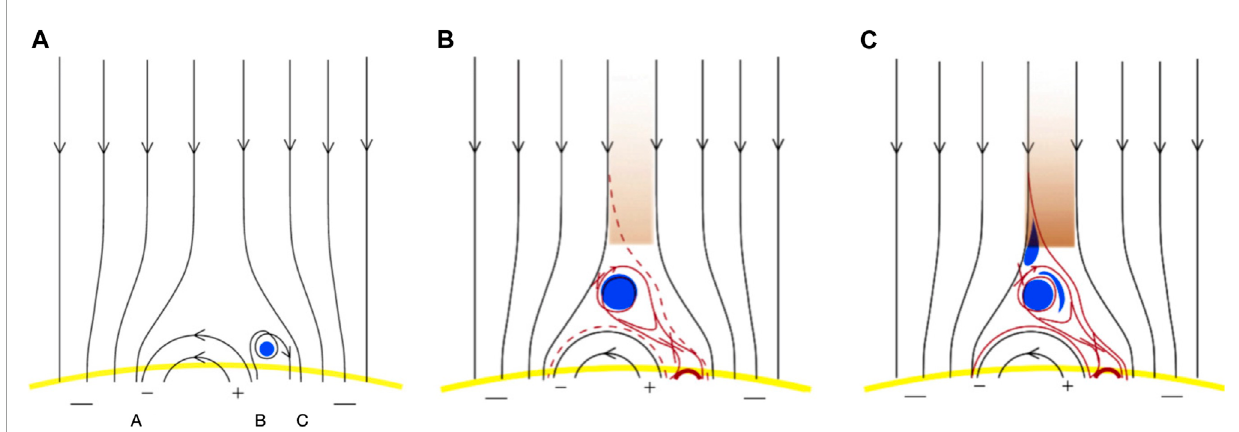
FIGURE 2 Schematic showing the minifilament-eruption mechanism for coronal jets, from Sterling et al. (2015) (this slightly modified version of the original figure appeared in Sterling et al., 2018). This is a two-dimensional cross-sectional cut of the jetting region, with the yellow curve representing the Sun’s limb. Black lines represent magnetic field lines prior to reconnection, with the arrow heads and the “+” and “−” signs indicating polarities. Red lines indicate reconnected field lines, with the dotted red lines indicating that the field lines are newly reconnected. The blue circle indicates cool minifilament material, with the circular field surrounding it being the minifilament’s field. Panel (A) shows the situation prior to eruption. “A,” “B,” and “C” indicate locations for reference. In (B) the minifiament’s field is erupting, carrying with it the cool minifilament material. Red X-es show reconnections, with the one below the erupting minifilament being flare-like reconnection (called “internal” reconnection, being internal to the erupting flux-tube’s lobe field; Sterling et al., 2015) resulting in the jet bright point (JBP), represented by the thick-red simicircle between the B and C locations. The reconnection in front of (to the left and slightly above the center of) the erupting minifilament (“external” reconnection) results in new open field, along which heated plasma flows to form the coronal jet’s spire (shaded region). This reconnection also adds new heated closed field above the magnetic lobe between locations A and B. In (C) the higher-height reconnection has proceeded enough that some of the cool minifilament material is flowing out onto the spire on newly reconnected open